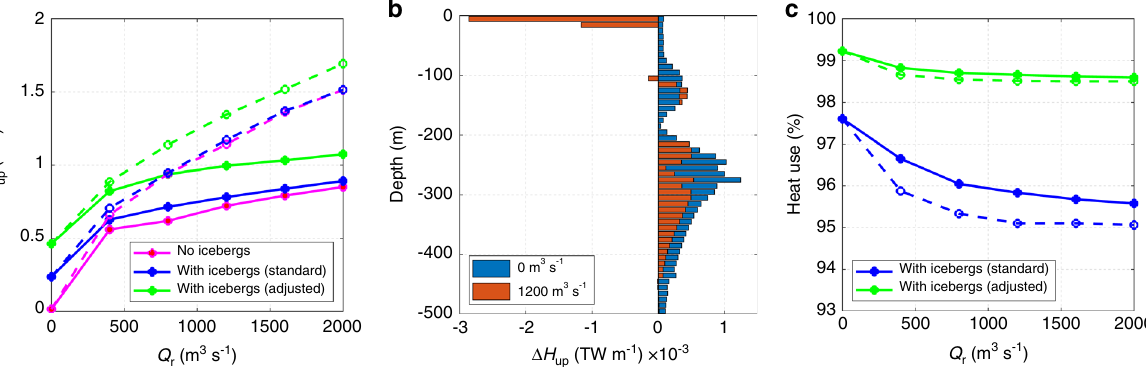
Fig. 6 The effect of icebergs on along-fjord oceanic heat fl ux. a Relationship between runoff ( Q r ) and up-fjord oceanic heat fl ux ( H up ) across our fl ux gate (location in Fig. 1a) in our no-iceberg scenario and in our iceberg scenarios with both the standard and adjusted melt rate parameter values (Methods). b Change in up-fjord heat fl ux ( Δ H up ) due to icebergs (where a negative value indicates a decrease in heat fl ux with icebergs at that depth) for the no- runoff (blue) and summer runoff forcing (orange) scenarios. c The percentage of heat used for ice melt within the fjord accounted for by iceberg melting. In a and c , the solid lines represent our ‘ channelised ’ drainage scenario and the dashed lines represent our ‘ distributed ’ drainage scenario.